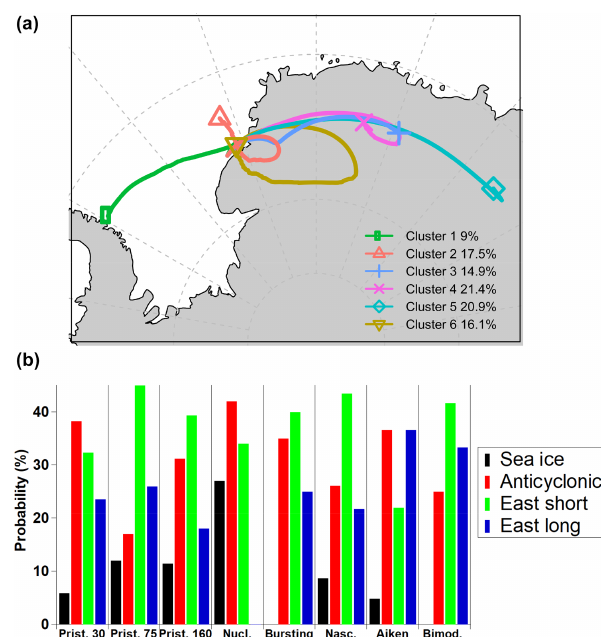
Figure 4. (a) Air mass analysis of air mass back trajectories arriving at Halley during the year 2015 (hourly resolution) and (b) relative contribution for each aerosol category. Groups in (b) are sea ice (1), anticyclonic (2, 6), east short (3, 4) and east long